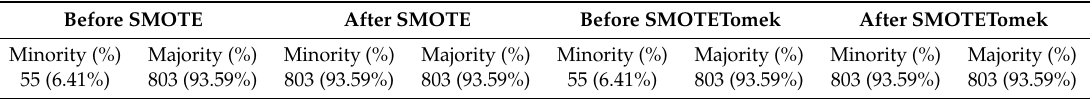
Table 5. Results of synthetic minority over sampling technique (SMOTE) and